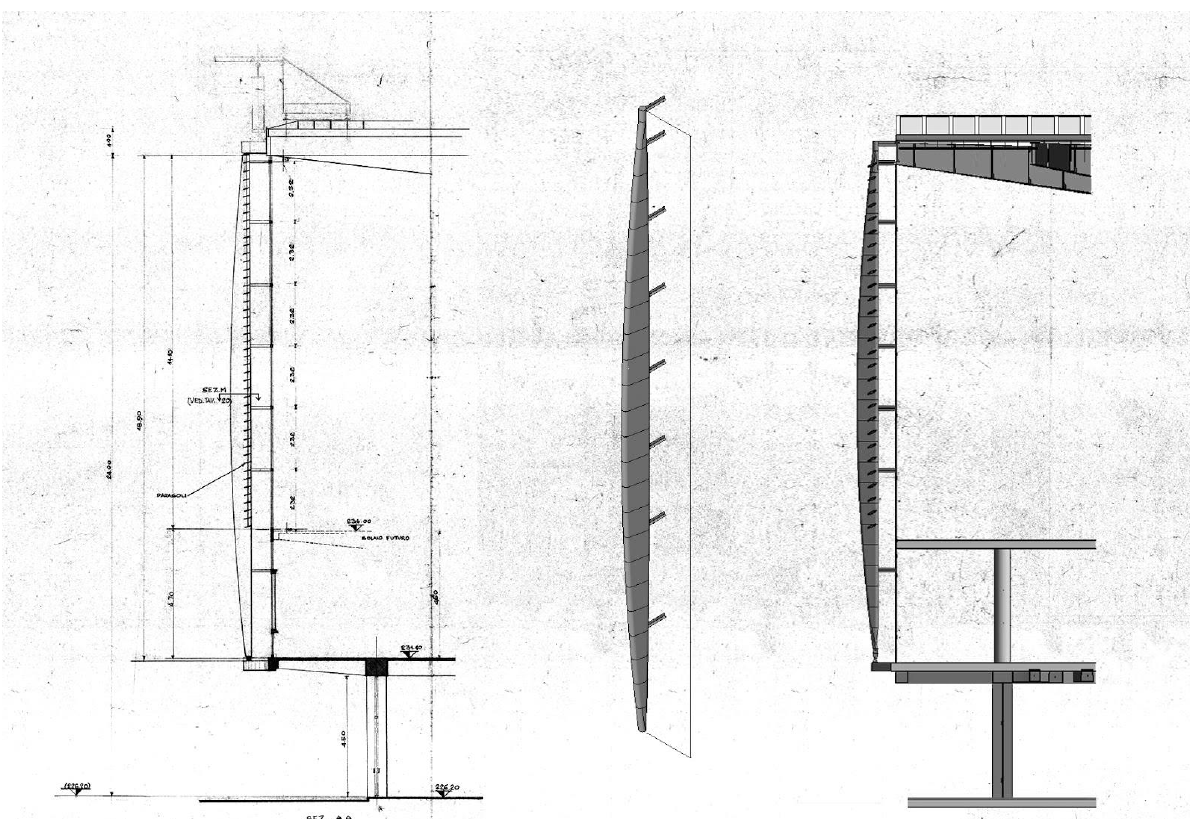
Figure 2: comparison between the Nervi’s layout Detail Prospectus n16, Fiat Engineering archive, (on the left) with a vertical section of the BIM model and detail of the Ritto family (in the center and on the